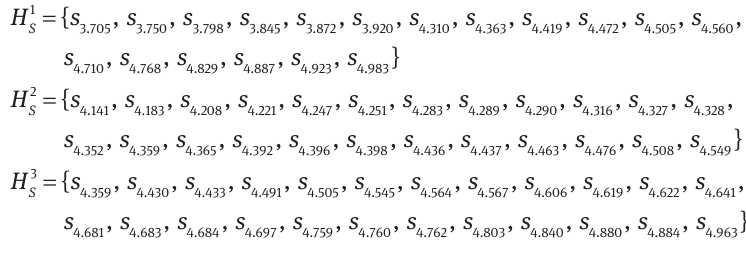
Table 7: Score Values by the Operators and the Rankings for the Alternatives.